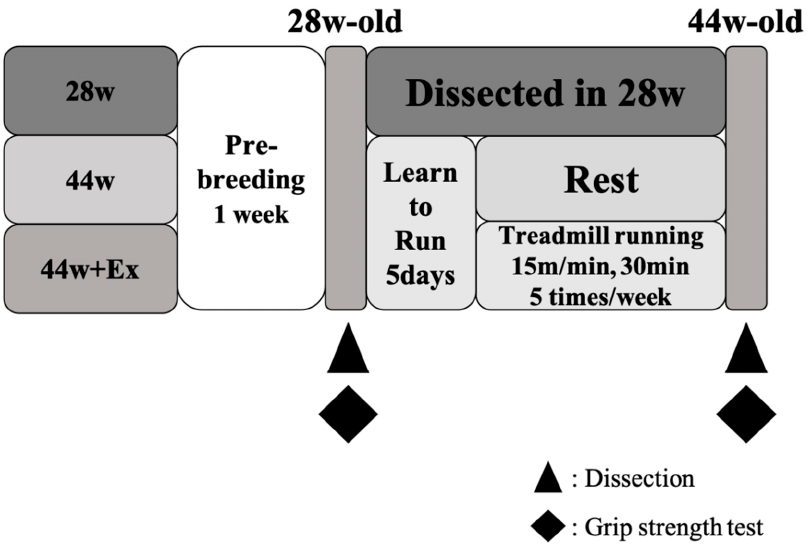
Figure 1. Overview of this study .